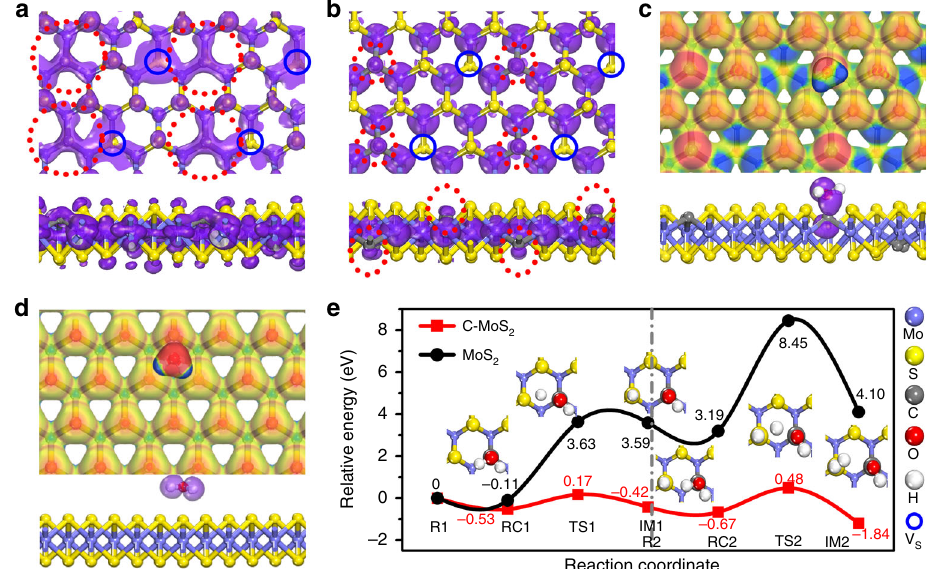
Fig. 5 The structural analysis and the catalytic pathway of C – MoS 2 . The top-view and side-view sp 2 hybrid orbitals (highlighted by red dash circle) at the top of valence band ( a ) and the empty 2p orbitals (highlighted by red dash circle) perpendicular to the basal plane at the bottom of conduction band ( b ) of C – MoS 2 . The top-view electrostatic potential of water adsorbed on the basal plane of C – MoS 2 ( c ) and MoS 2 ( d ) and the corresponding side-view bonding and non-bonding orbitals. e The relative energy diagram along the reaction coordinate, including the fi rst (left panel) and second (right panel) water dissociation process on the basal plane of MoS 2 and C – MoS 2 , respectively. R reactant, RC reactant complex, TS transition state, IM